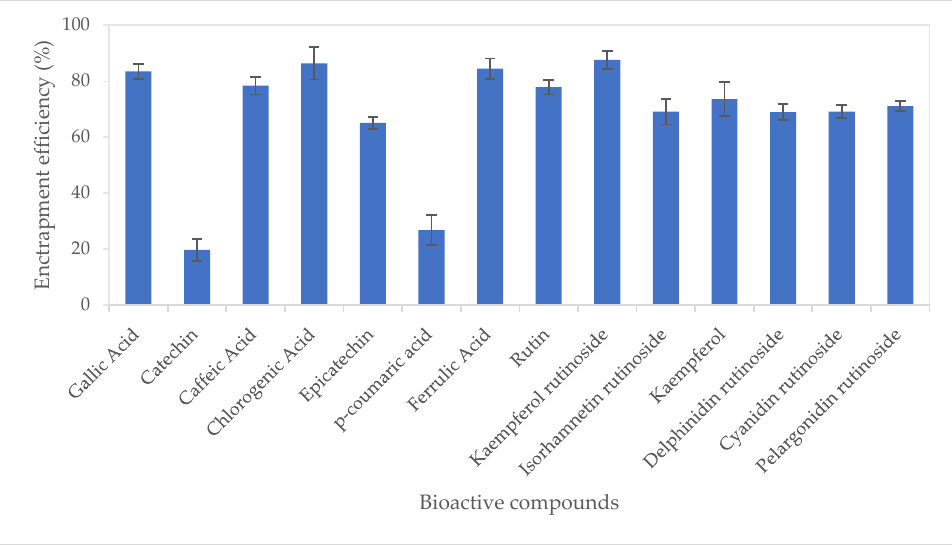
Figure 2. Entrapment efficiency of polyphenols from tamarillo extract using lyotropic liquid crys- talline nanoparticles. Data are presented as mean and error bar (standard deviation) ( n = 3).